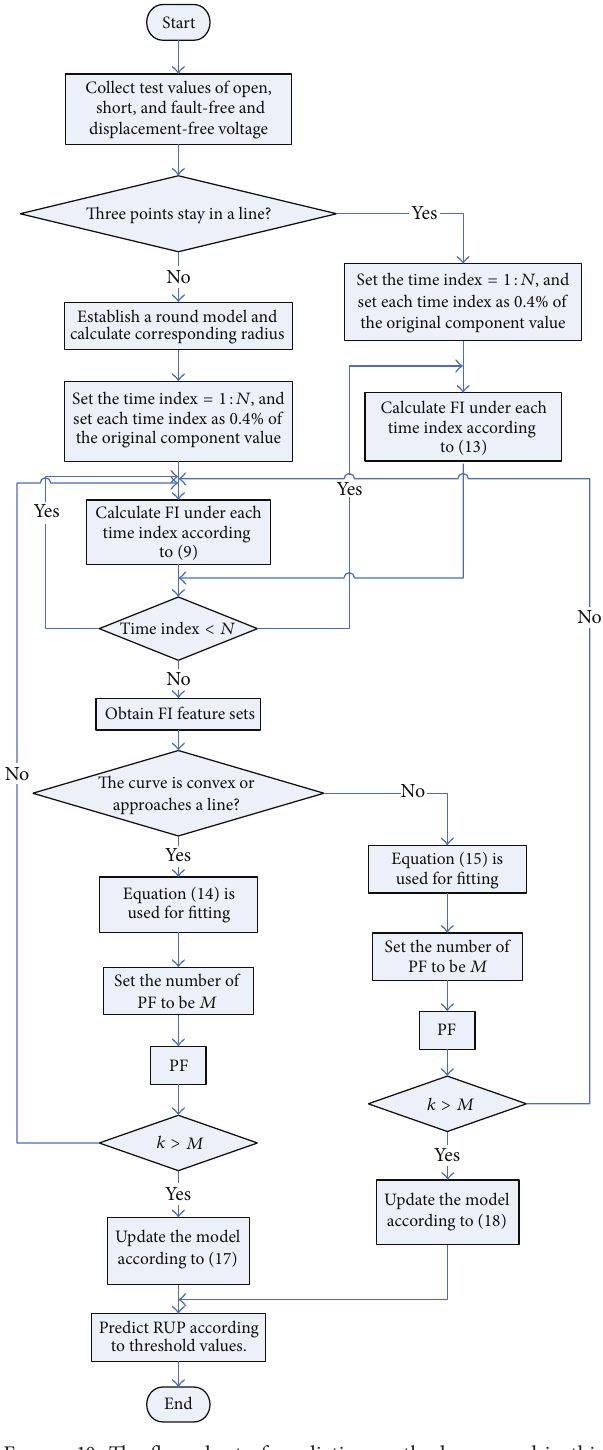
Figure 10: The flow chart of prediction method proposed in this paper about single components based on complex field modeling. is concave, (15) is used for fitting. Repeat Steps 3 and 4 to collect a parameter set of